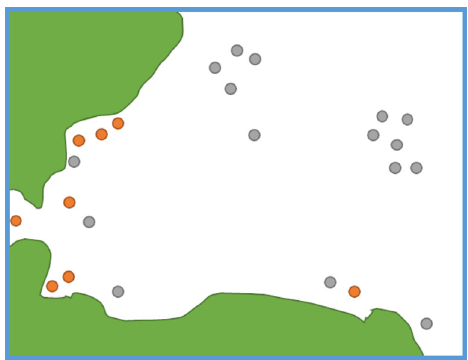
Fig. 6. An example of a visual analysis of classification results: grey – objects classified correctly, orange – objects classified incorrectly. This shows